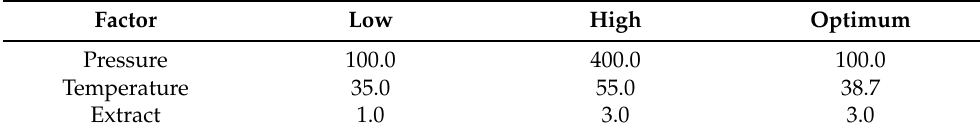
Table 4. Low and high values of explanatory variables and optimized condition